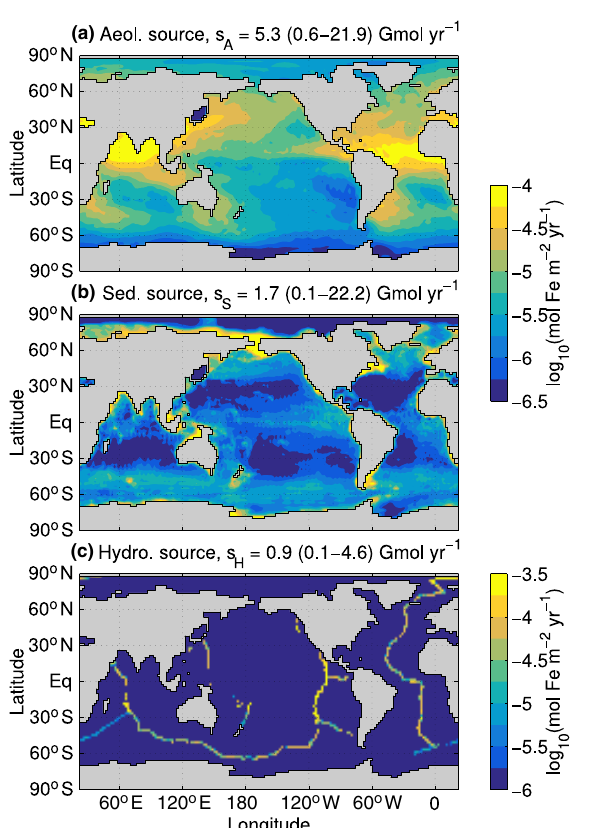
Figure H1. Vertically integrated sources of aeolian (top, a ), sedi- mentary (middle, b ), and hydrothermal (bottom, c ) iron for our typ- ical state estimate. Note the logarithmic color scales. The globally integrated sources for the typical estimate are indicated in the plot titles together with their ranges across the family of estimates in parentheses.